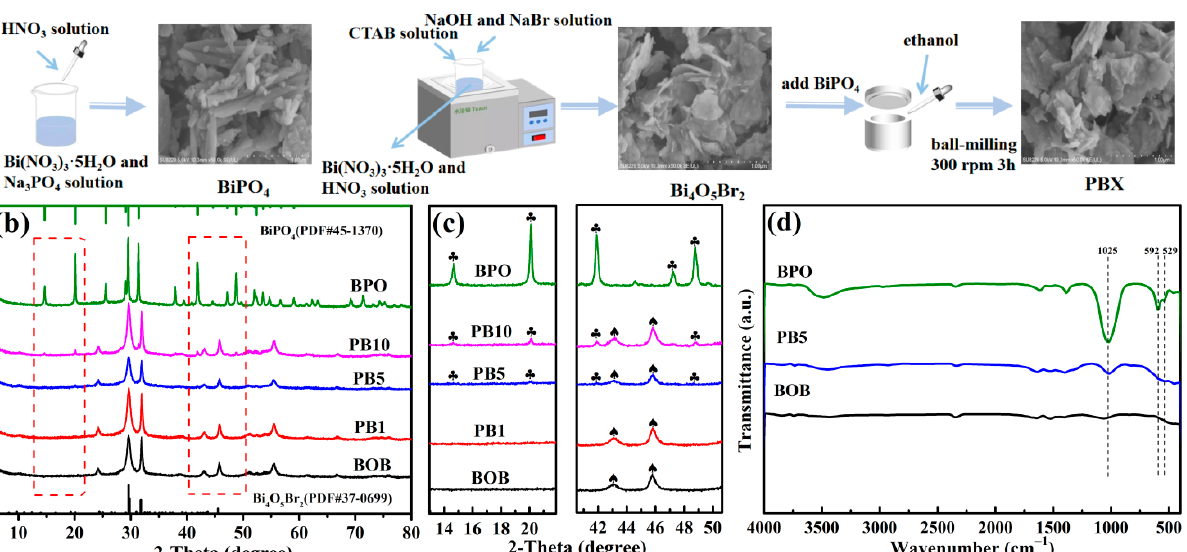
confirmed by the following analytical techniques.